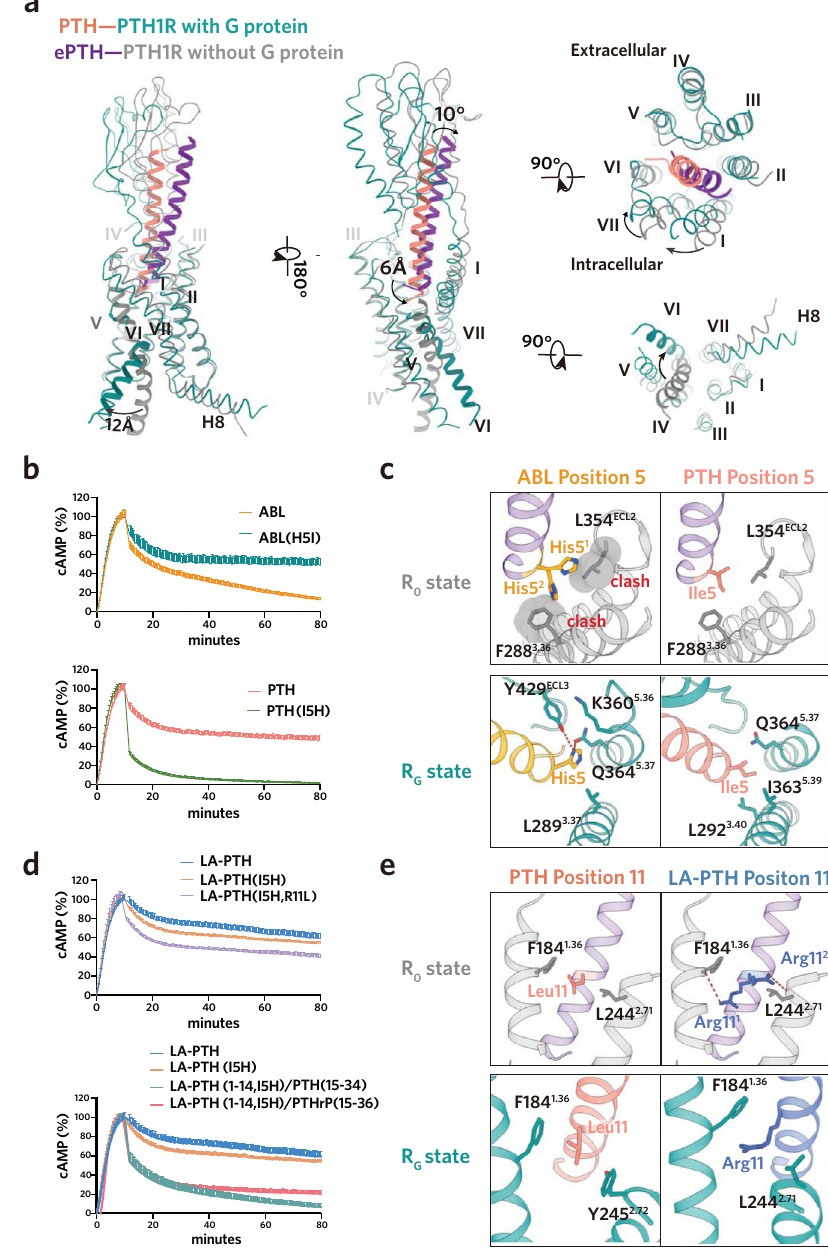
Fig. 4 | Molecular basis for the prolonged and transient cAMP signaling of PTH1R. a Structural comparisons of the peptide – bound PTH1R with and without G-protein coupling (ePTH – bound; PDB 6FJ3). b, d , Duration of cAMP signaling responses induced by PTH, ABL and LA-PTH analogs. c, e Interactions of the